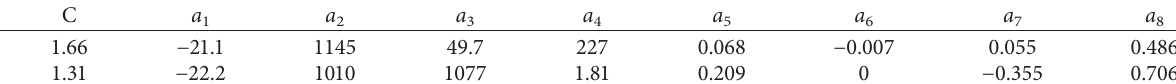
Table 2: Tire fitting parameters.